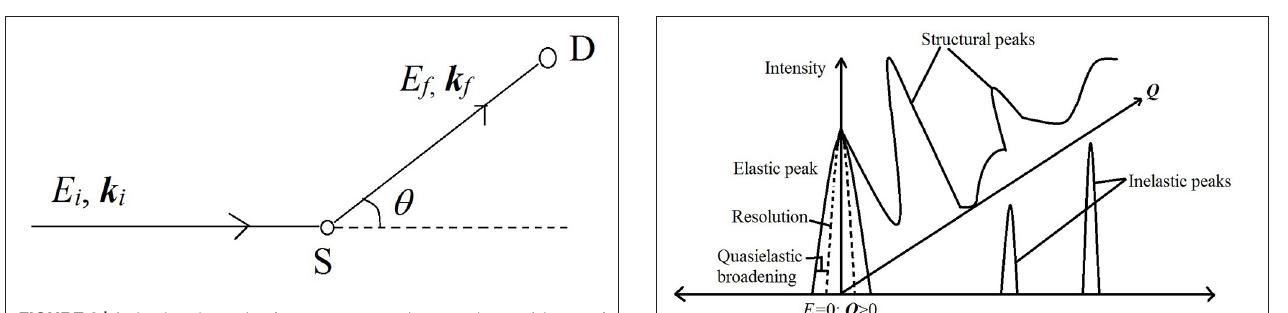
FIGURE 2 | A simple schematic of a neutron scattering experiment. A beam of neutrons with energy E i and momentum -h k i is scattered by the sample (S) and after exchanging some energy and momentum with the sample, the beam is detected by the detector (D) with a final energy E f and momentum -h k f . The scattering event deflects the path of the neutron beam by an angle θ which defines the wavevector transfer in the scattering event.